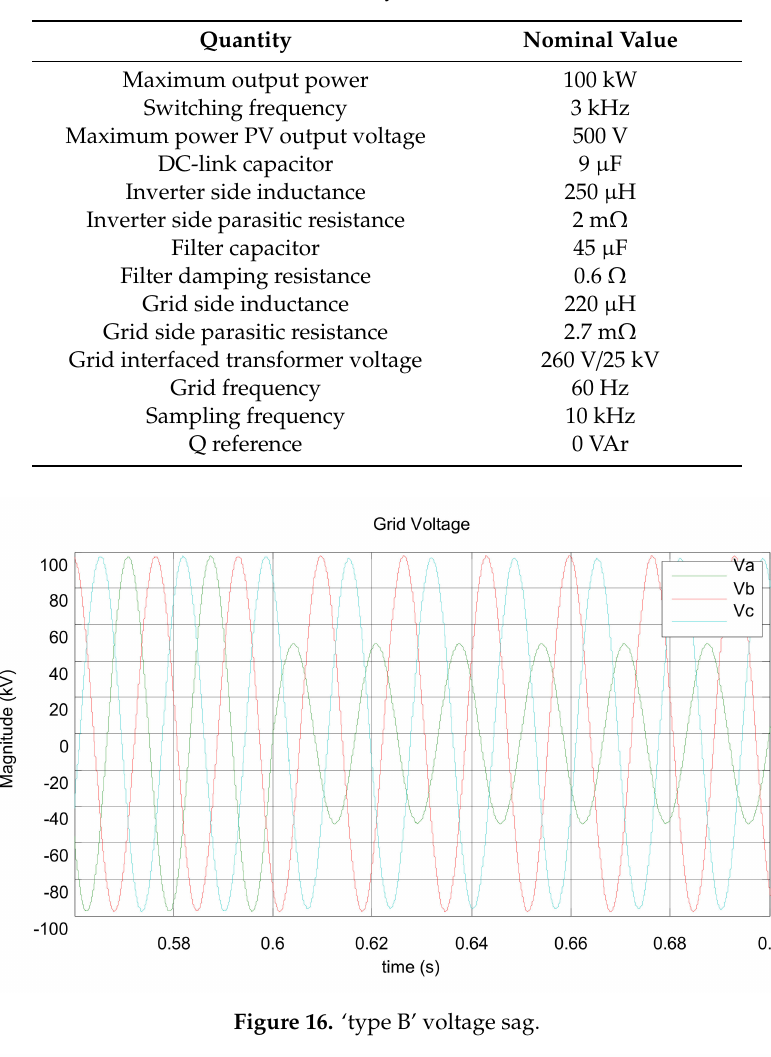
Table 2. PV system values.